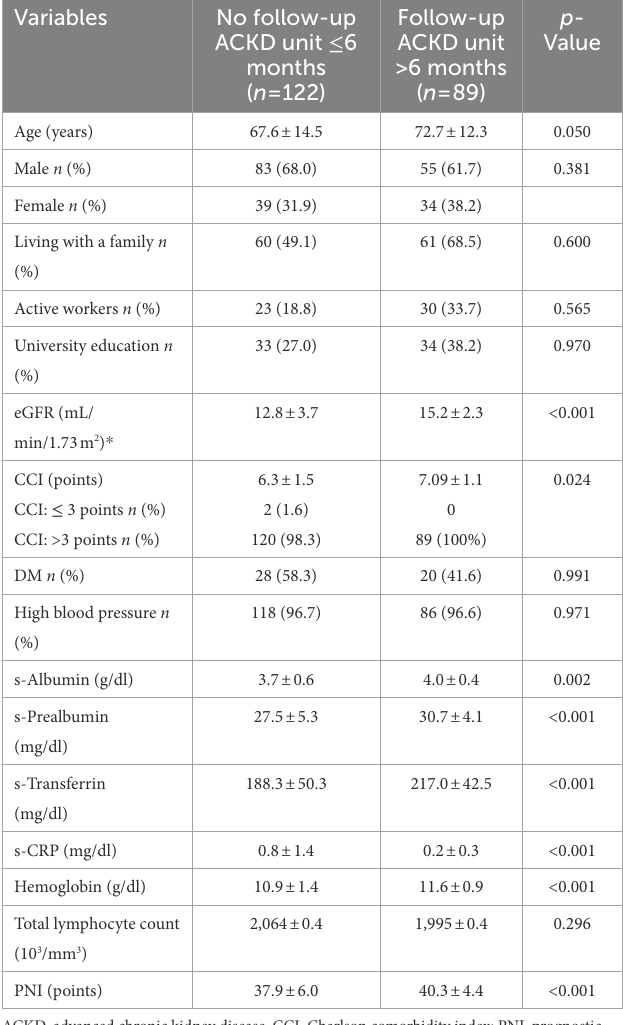
TABLE 2 Comparison of clinical and biochemical parameters of 211 participants in the study according to the time on follow-up in the ACKD